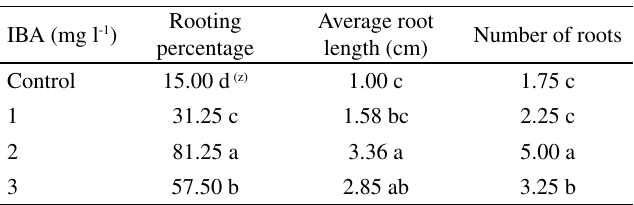
Table 2 - Effect of different concentrations of IBA on rooting of Dra- caena sanderiana